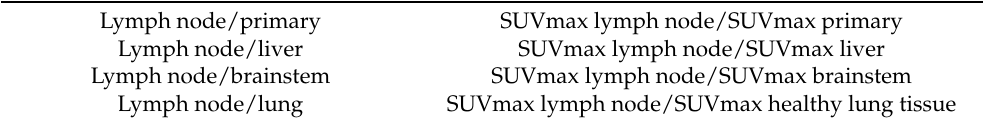
Table 1. Calculation of the named